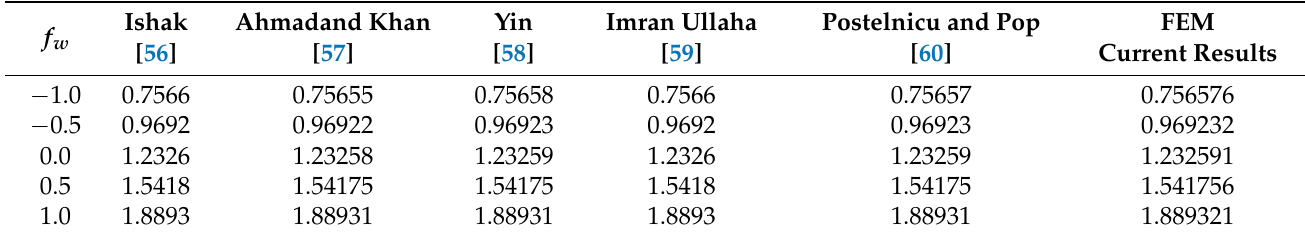
Table 3. Comparison of f (cid:48)(cid:48) ( O ) with f w when β = 1 and all other parameters are fixed zero.